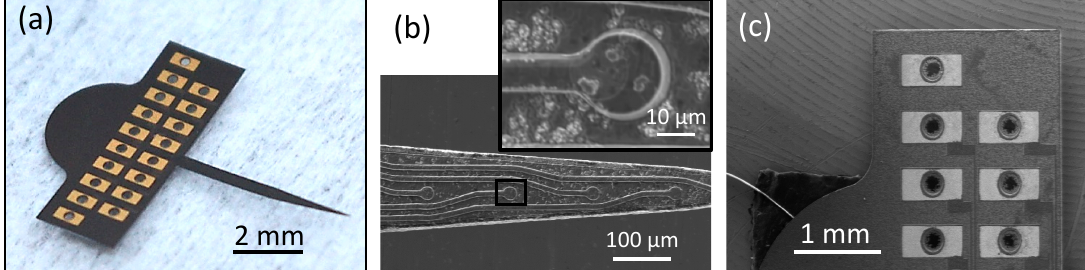
Figure 3. Physical characterization of the completed neural probe. ( a ) Optical image of a freestanding all-SiC probe after release. ( b ) SEM image of the shank tip showing four of the electrode sites and a magnified image of a single electrode site (inset). ( c ) SEM image of some of the metal contact pads with through holes. The shank is 5.1 mm long and the length of the tapered portion is 2.4 mm. The tab is 6.64 mm wide and 2.3 mm long, excluding the semi-circular top portion. The surface roughness of the electrode sites is shown in Figure 2c.